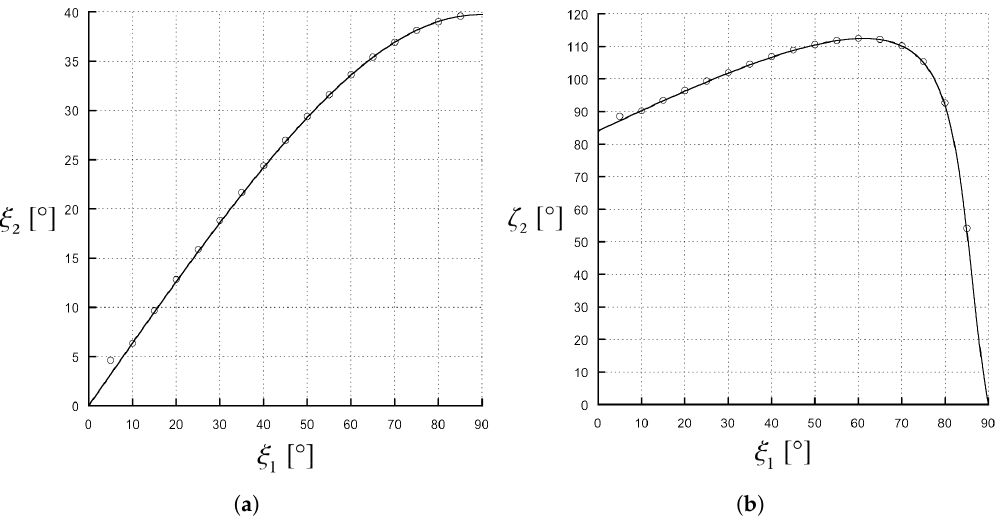
= 5, ε (cid:48)(cid:48) = 0.1 and β = 1.01 β 1 1 c . The angles 2 2